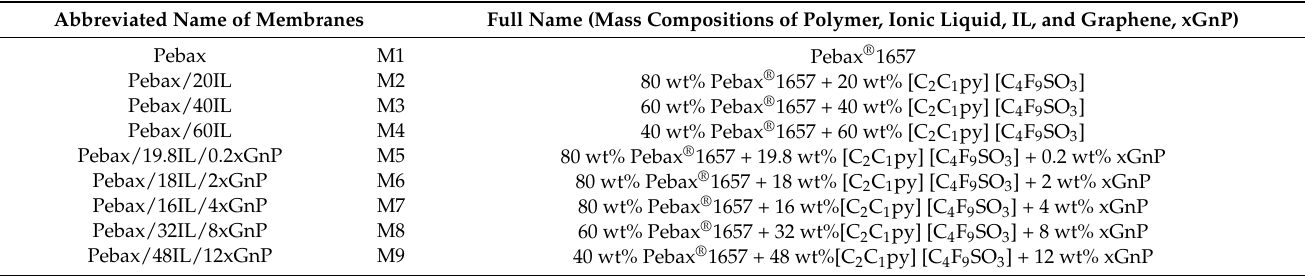
Table 1. Abbreviated name and full name (description of the membranes and ionanofluids (IoNFs)) studied in this work. Abbreviated Name of